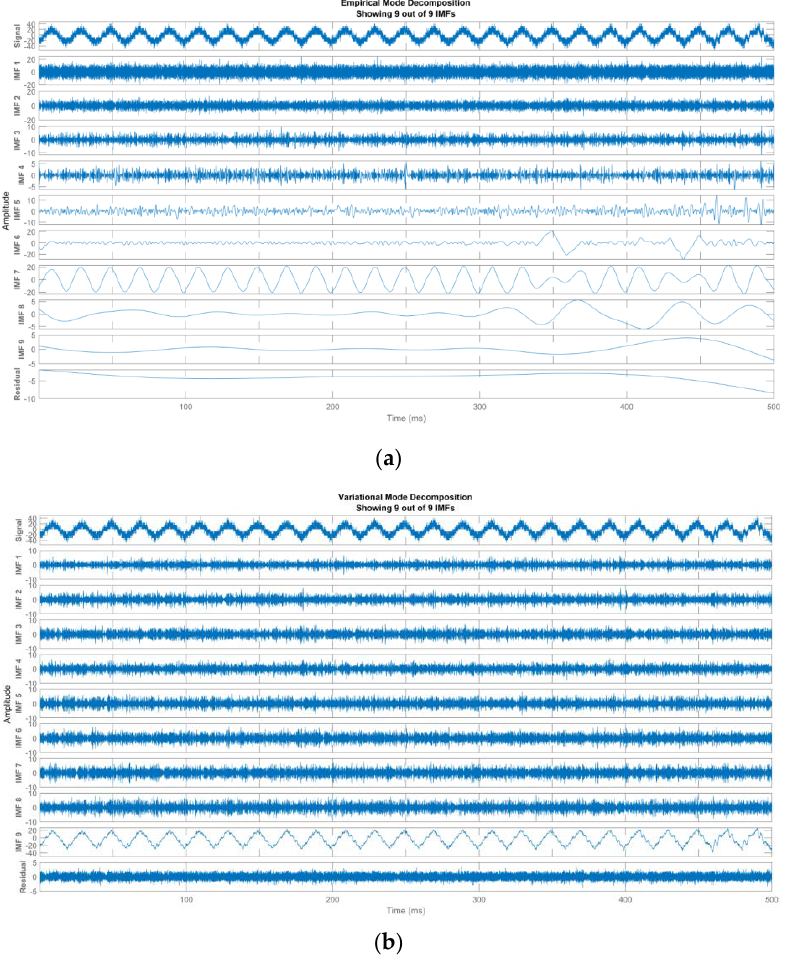
Figure 11. EMD ( a ) and VMD ( b ) decomposition of natural ester liquid current signal under disc electrode arrangement (d = 2 mm).